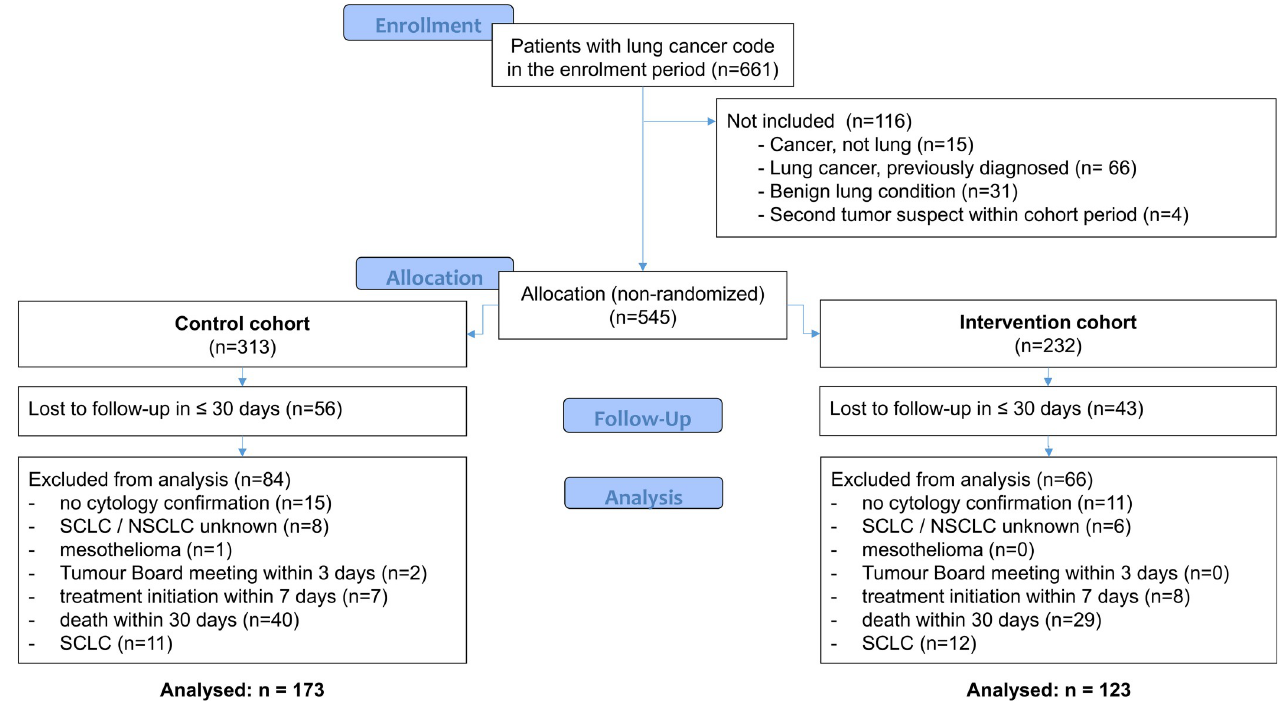
Fig 1. Patient enrollment CONSORT